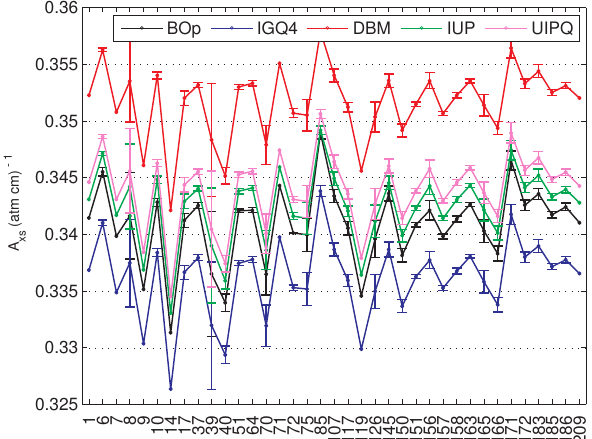
Fig. 4. Brewer ozone absorption coefficient or differential cross sec- tion for the Brewer instruments in the RBCC-E set; the values are the mean and the bars indicate the standard deviation for the an- alyzed cross sections. The Brewer instrument labeled as #1 is the “nominal” one; the x -axis notation is the individual Brewer serial